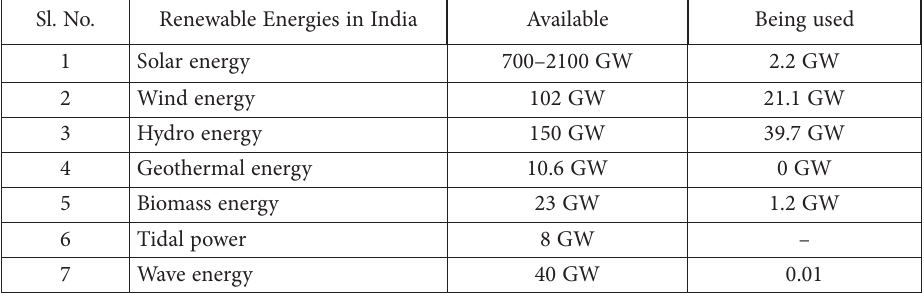
Table 1. Brief summary of India’s renewable energy potential (Luthra et al . 2015) Sl. No. Renewable Energies in India Available Being used Solar energy 700–2100